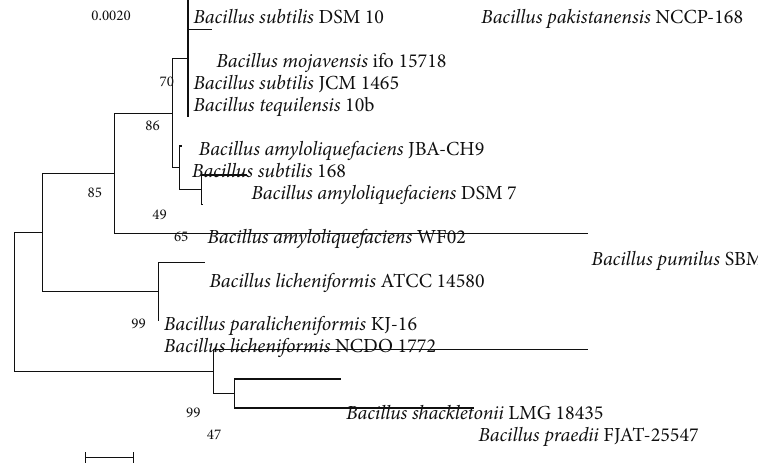
Figure 3: Phylogenetic tree of Bacillus amyloliquefaciens. Table 1: Factor level